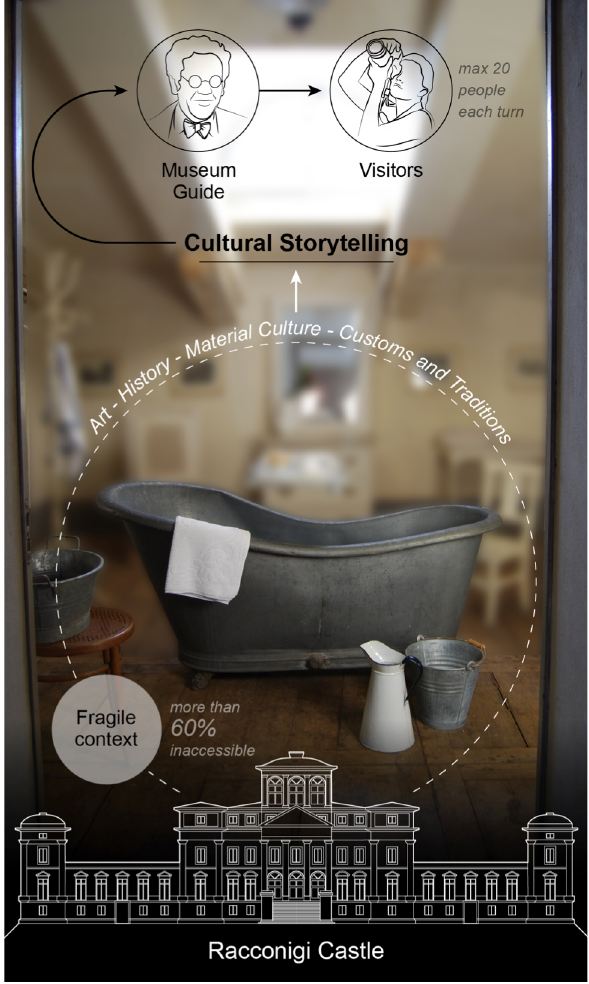
Figure 2 | The Racconigi Castle scenario